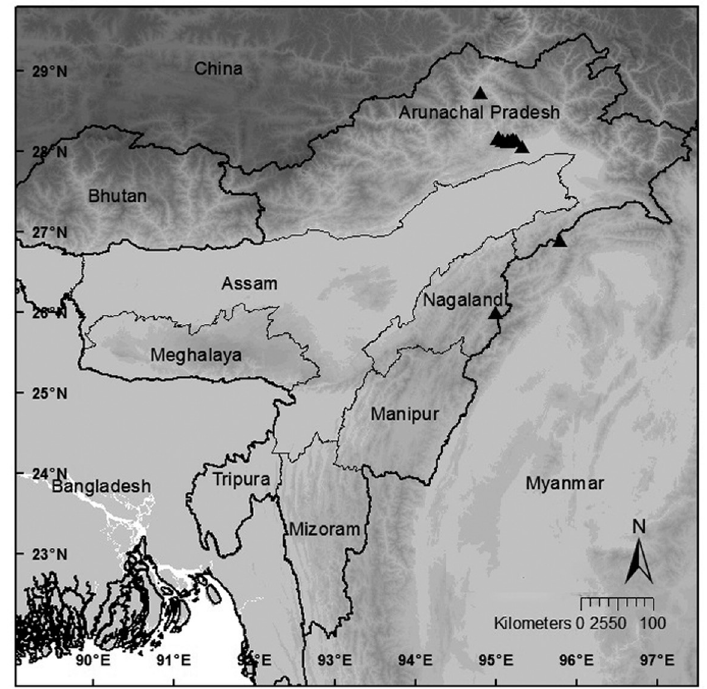
Fig. 5. Map showing the location of B. aborensis Dunn